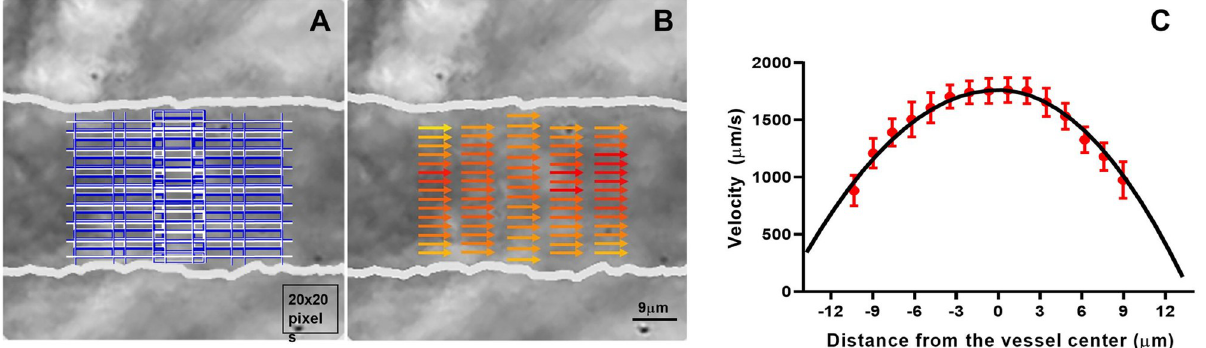
Fig 7. Measurement of blood flow velocity. (A) Automated generation of a mesh in the lumen of the blood vessel sub-image for measurement of blood flow. (B) Velocity vectors indicates the direction of blood flow. Color ranges from light yellow at the minimum velocity to deep red at maximum velocity detected. (C) Measured speeds (red dots) were fitted with the parameter k = 2 (black